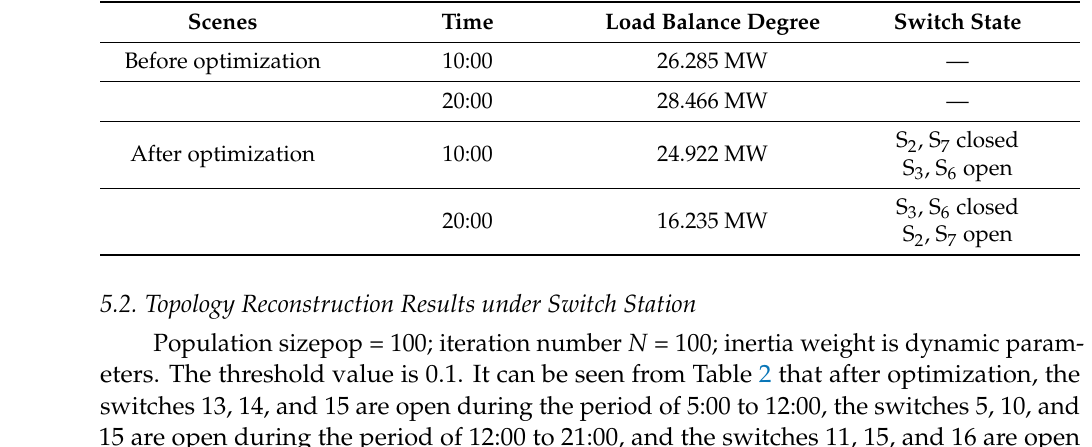
Table 1. Comparison of feeder layer load balance.